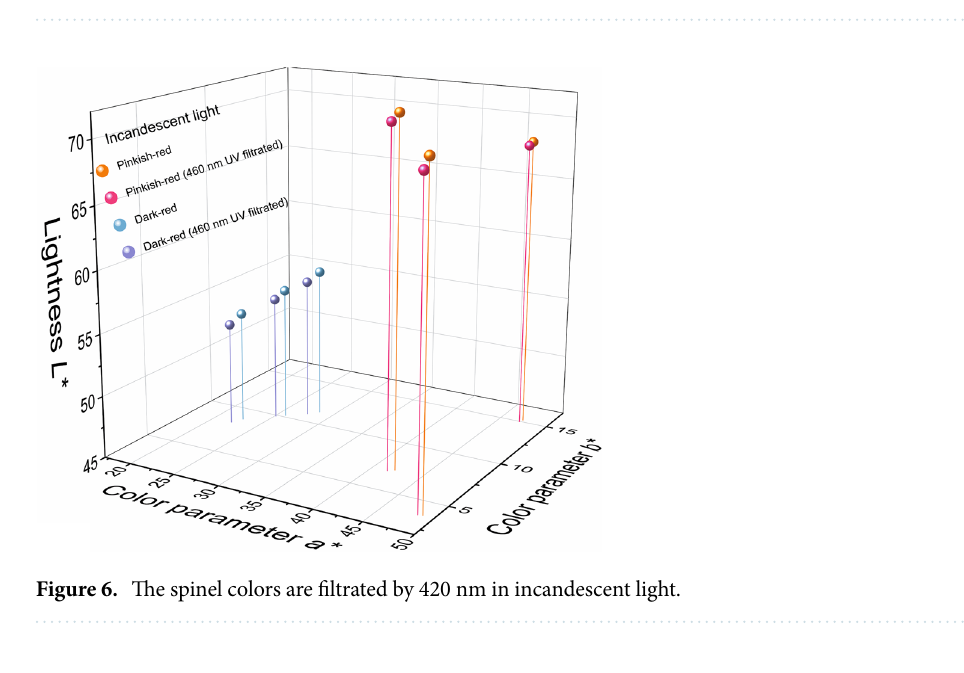
Figure 5. The spinel colors were filtrated by 420 nm in daylight.